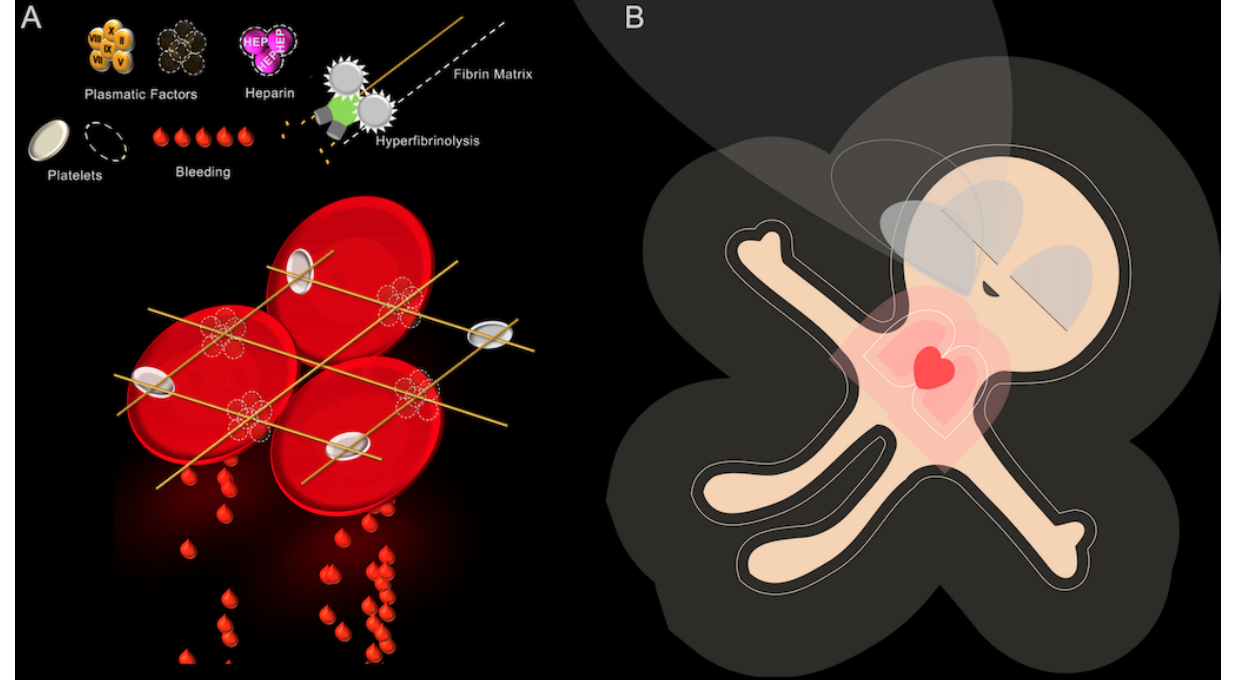
Figure 1. Graphic showing the Visual Clot and Visual Patient technologies. (A) Bleeding Visual Clot illustrated with its different coagulation components. These are either present or absent, depending on the coagulation status. (B) Visual Patient with its different visualizations of vital